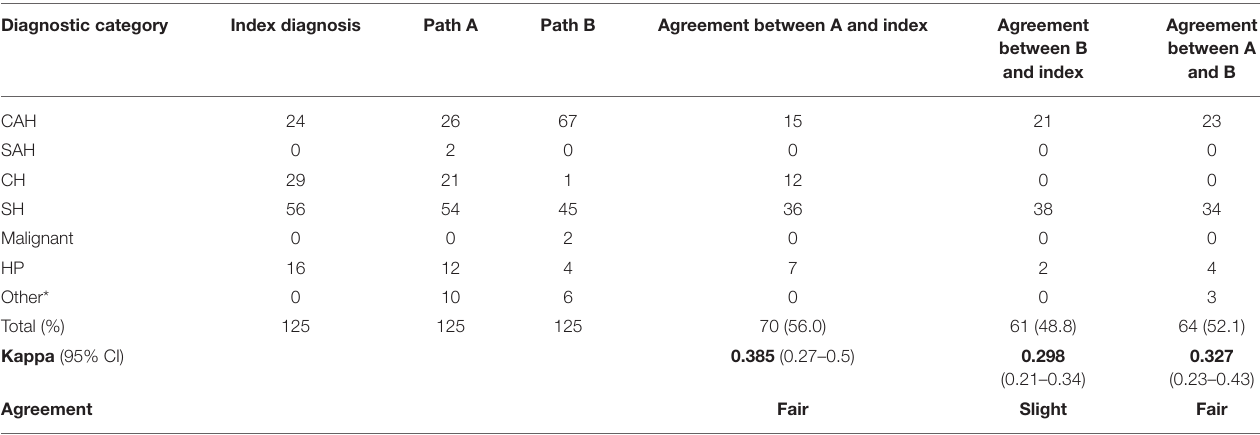
TABLE 1 | Comparison between endometrial hyperplasia diagnosis by independent pathologists using WHO94 classification revealed discordant findings. Diagnostic category